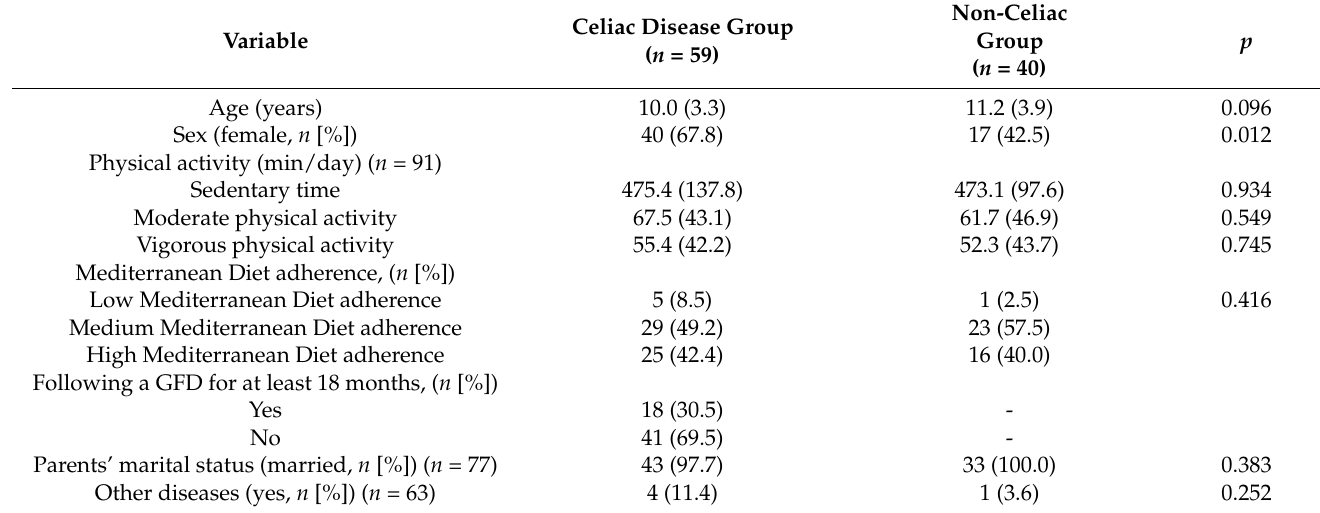
Physical activity, Mediterranean Diet adherence, sociodemographic and clinical characteristics of the study